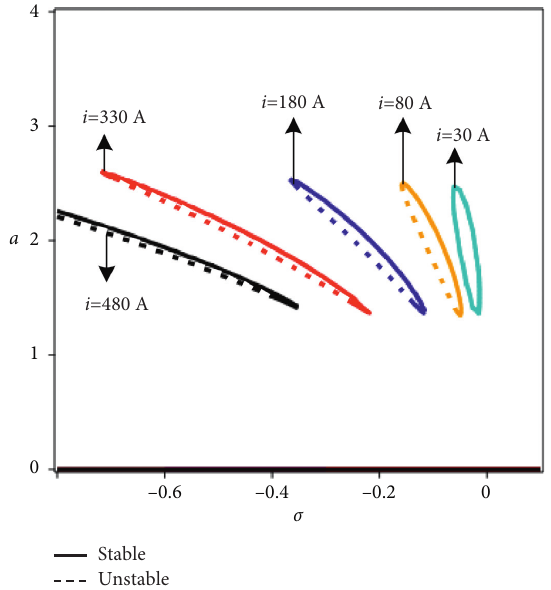
Figure 17: The 1/3-order subharmonic amplitude-frequency re- sponse curve (varied i